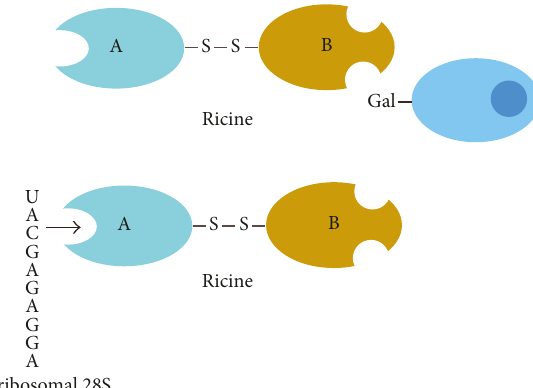
Figure 8: Diagram of the structure of ricin and its binding sites [19].